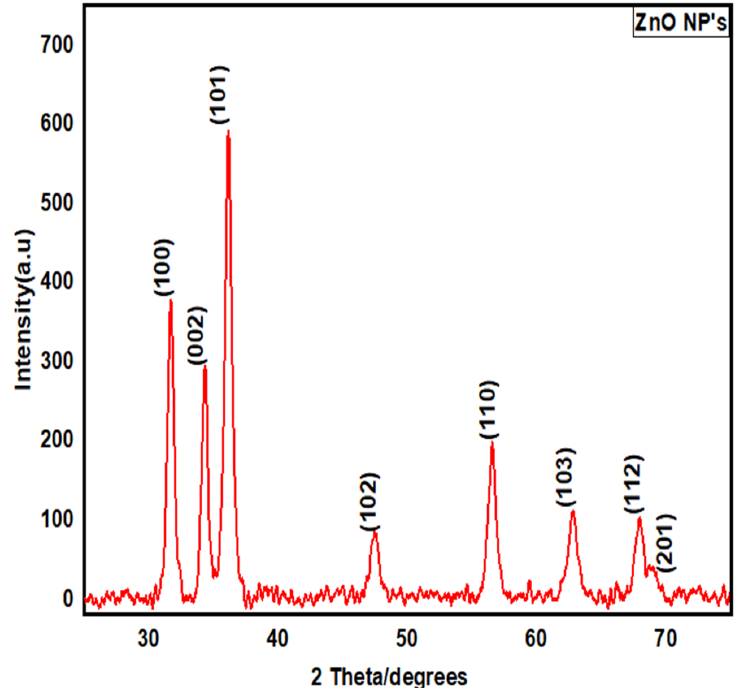
Figure 5. XRD spectrum of mycosynthesized ZnO